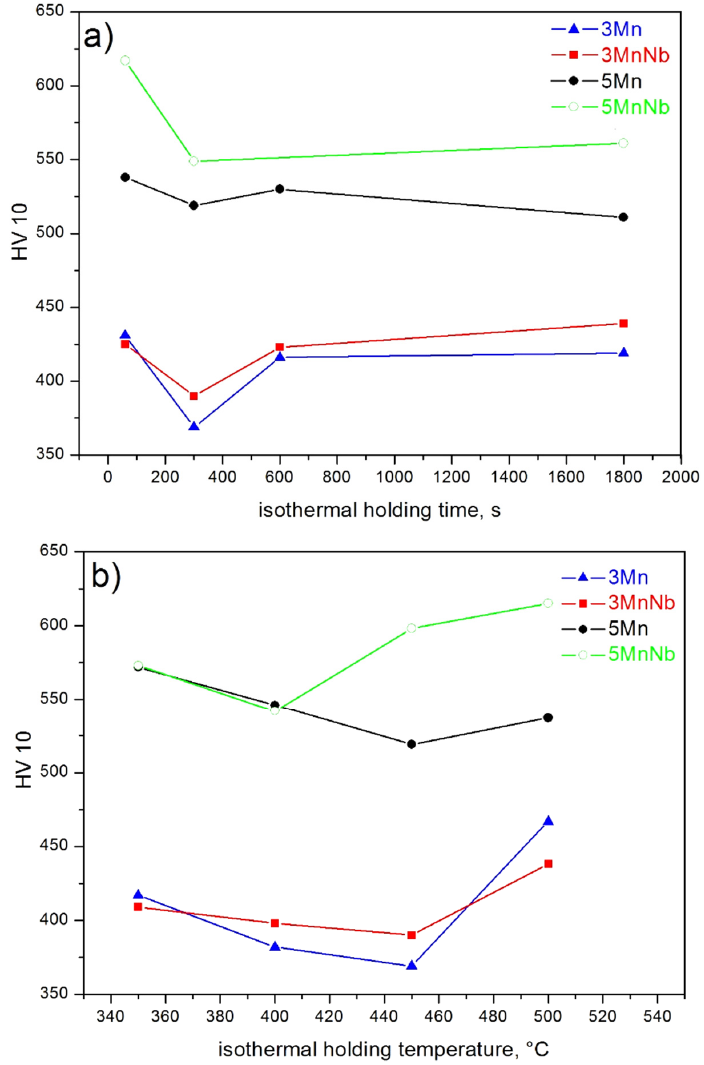
Figure 6. ( a ) Influence of isothermal holding time at 450 °C on the hardness; ( b ) Influence of isothermal holding temperature for 300 s on the hardness.